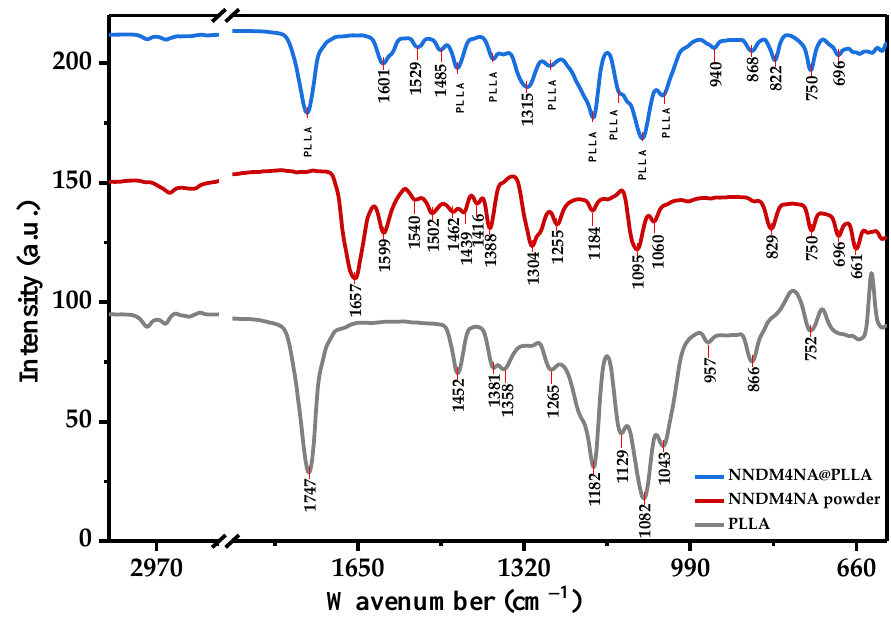
Figure 3. FTIR-ATR spectrum of PLLA (gray line), NNDM4NA powder (red line) and FTIR-ATR spectrum of PLLA (gray line), NNDM4NA powder (red line) and NNDM4NA@PLLA fiber array (blue line). NNDM4NA@PLLA fiber array (blue